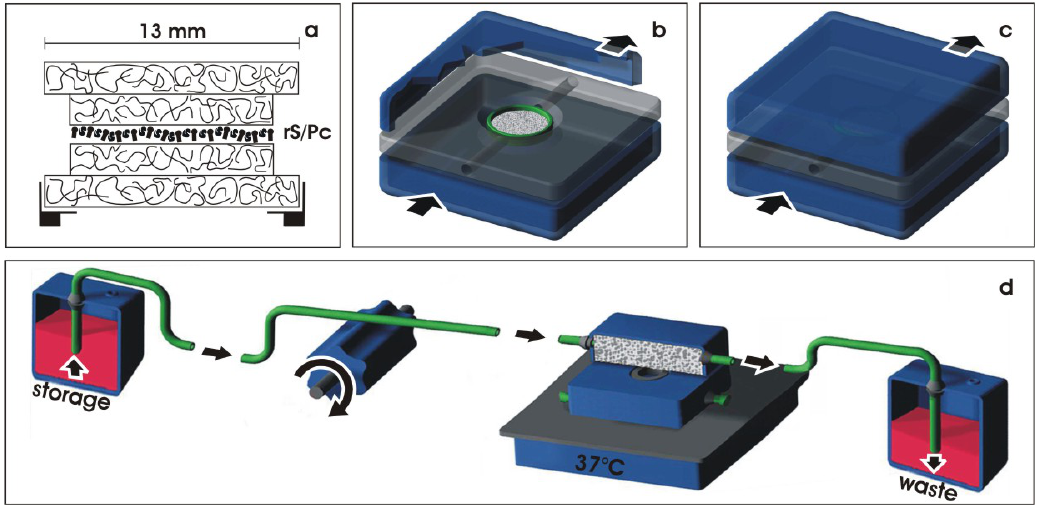
Figure 4. Set-up for perfusion culture. (a) Basic sandwich set-up containing renal stem/progenitor cells (rS/Pc) is mounted in a tissue carrier. (b) For culturing, the tissue carrier is placed at the base of a perfusion container. (c) After closing the lid, the tissue carrier is held in position. (d) Perfusion culturing is performed with a peristaltic pump transporting (arrow) always fresh medium (1.25 mL/h) from the storage bottle to the culture container. Used medium leaving the culture container is not recycled but is collected in a waste